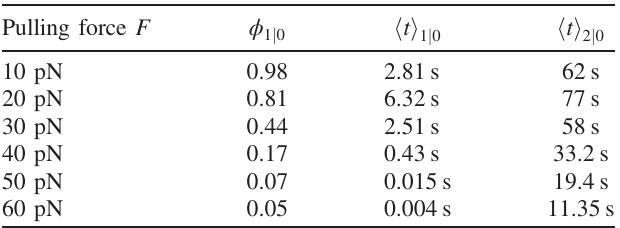
TABLE V. Asymmetry of the mean rupture time. The respectively. We highlight the results with a strong